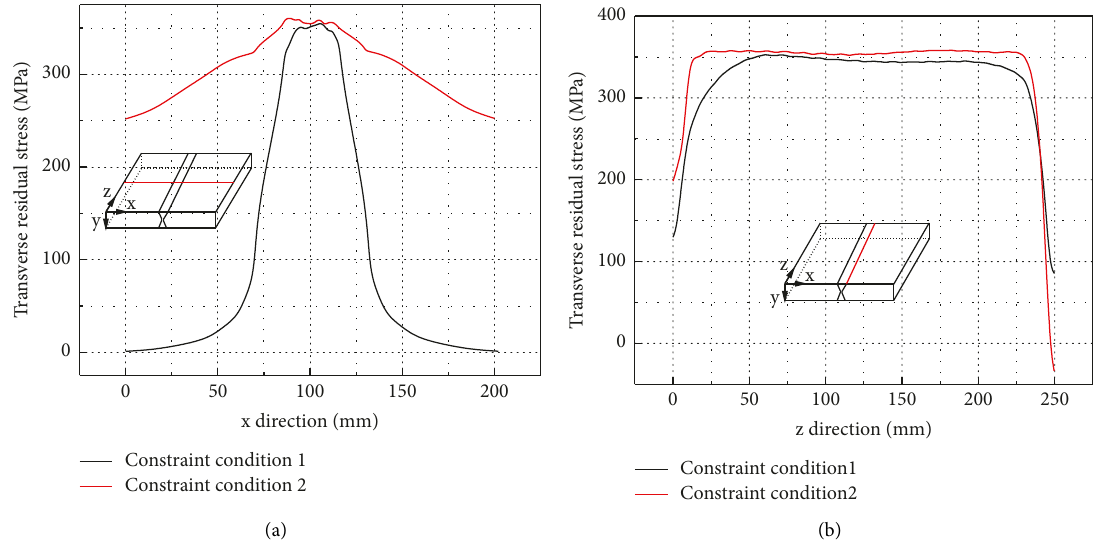
Figure 22: Effect of the constraint conditions on the transverse residual stress. (a) Transverse residual stress of path 1. (b) Transverse residual stress of path 2.